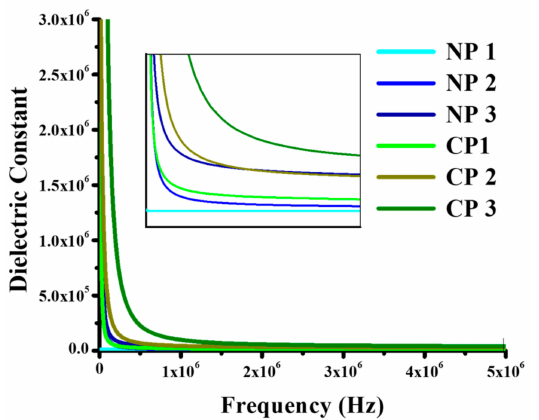
Figure 6. The graphs between dielectric constant verses ln F(Hz) for the samples; NP1; PVA/NiO (0.01 g), NP2; PVA/NiO (0.02 g), NP3; PVA/NiO (0.03 g), CP1; PVA/CuO (0.01 g), CP2; PVA/CuO (0.02 g), CP3; PVA/CuO (0.03